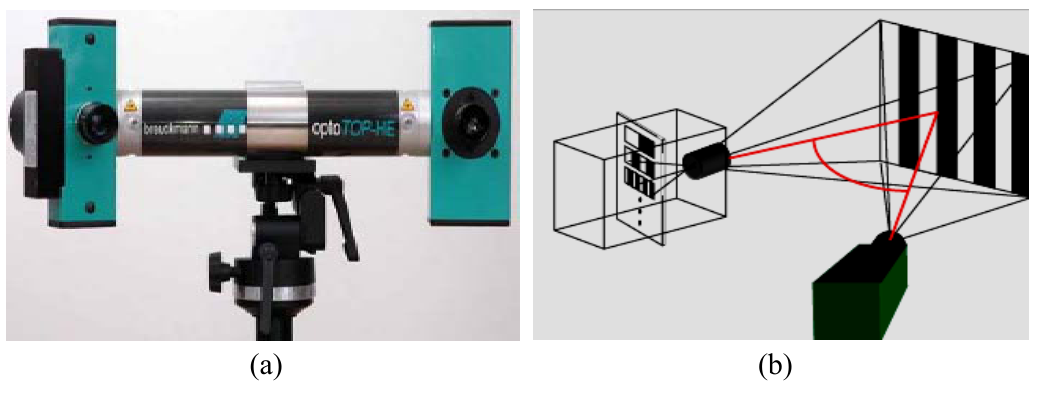
Figure 2. Breuckmann Opto-TOP digitizing system: (a) image of the instrument; and (b) Setup fringe projection